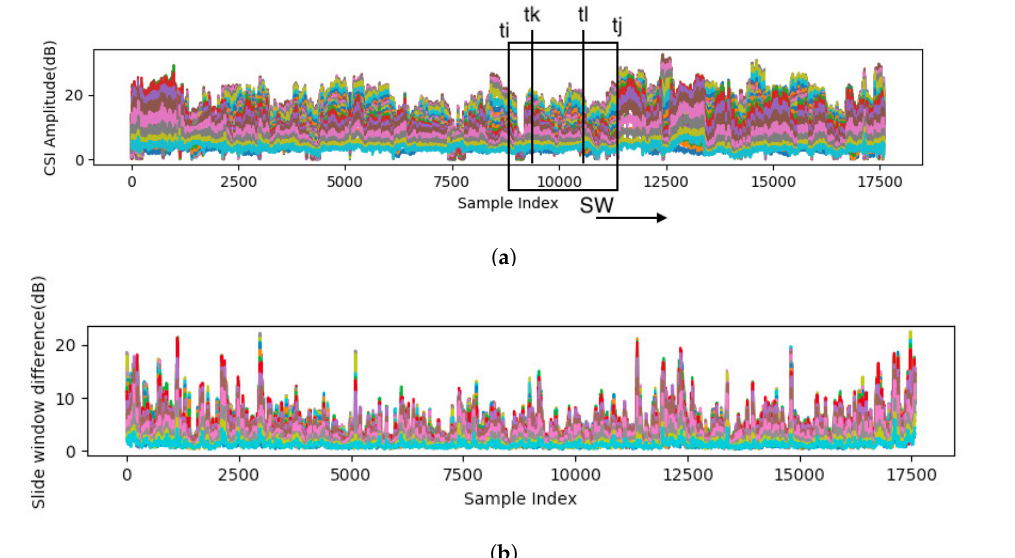
Figure 6. Example of slide windowing: ( a ) parameter and slide direction of slide window SW, and ( b ) calculated CSI difference ∆ CSI ( t j ) in each slide window.